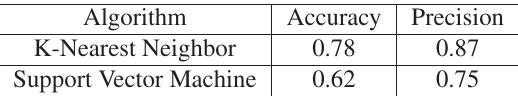
Table 1. Comparison Table Of